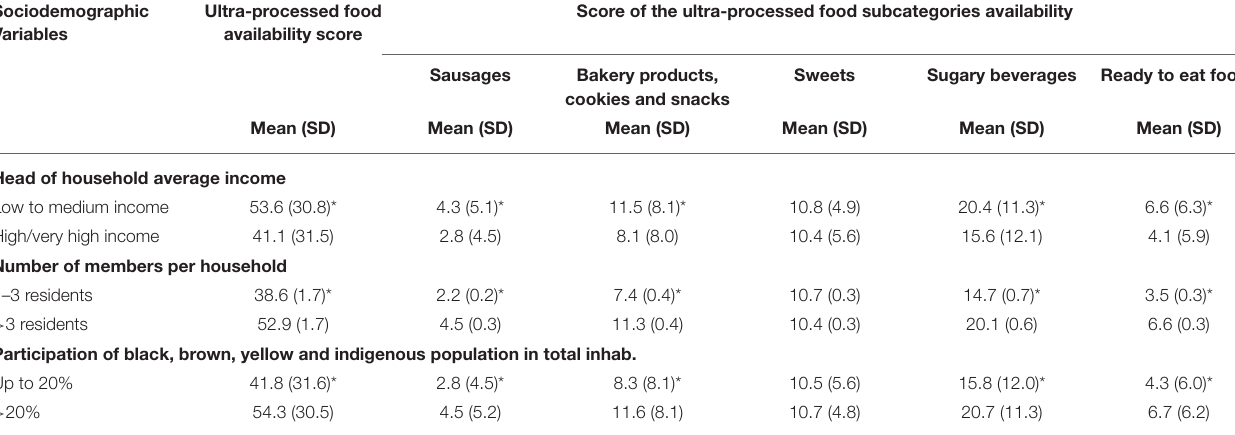
TABLE 3 | Ultra-processed food availability score and subcategories, according to sociodemographic variables. Sociodemographic Variables